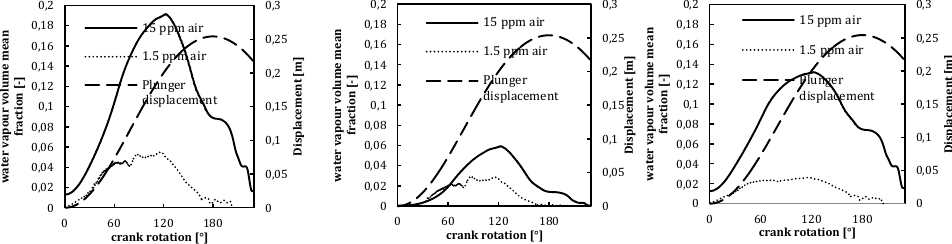
Figure 7. (Left) 2nd phase (water + air) volume fraction in the vicinity of the plunger when the air mass fraction is 15 and 1.5 ppm. (middle) Overall amount of vapour volume fraction. (right) overall amount of air volume fraction.